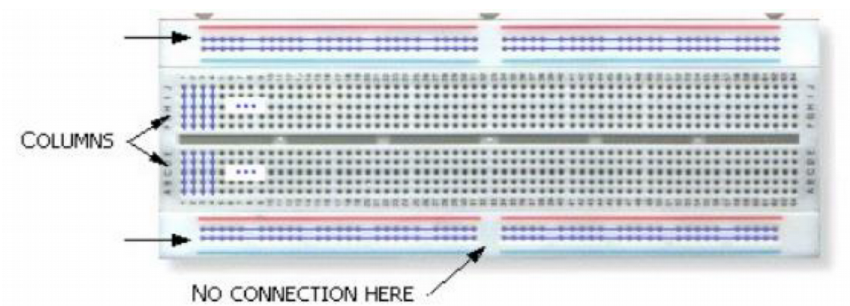
Figure 4. The pattern of protoboard in rows and